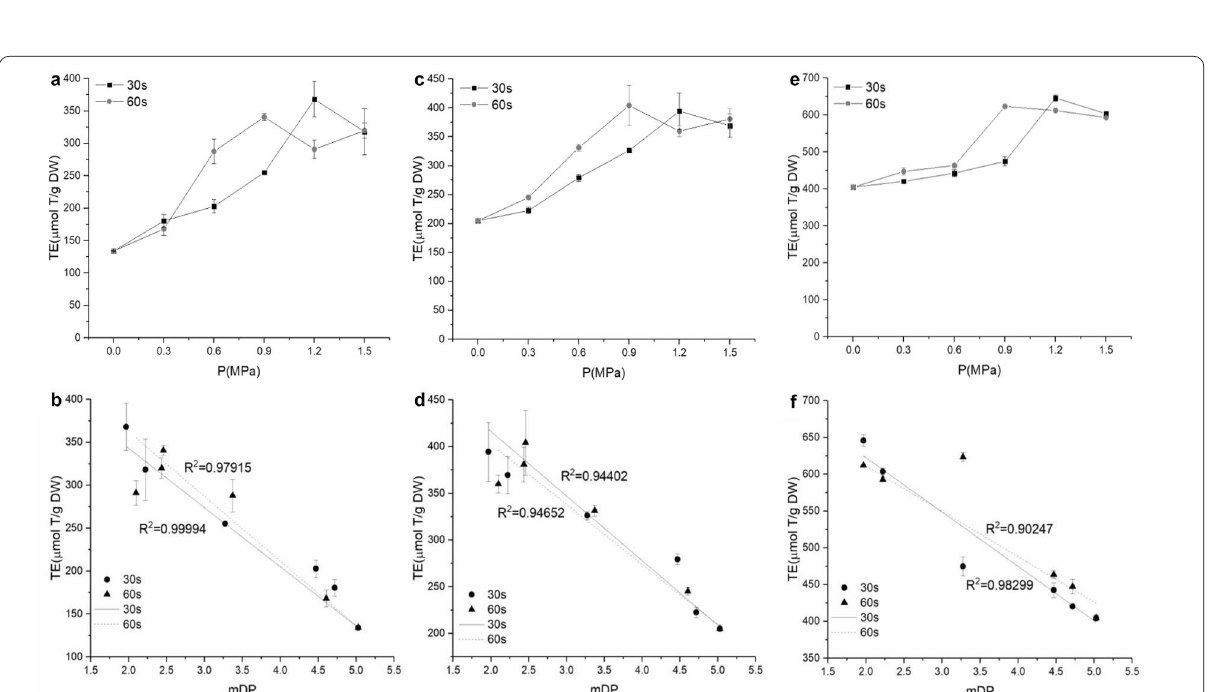
P Pressure (MPa), T Time of steam-explosion treatment (s). The results are described as the means different letters indicate significant differences, which were determined by One sample t -Test. (c:significance at P < 0.01; b:significance at P < 0.05; a:significance at P > 0.05.)